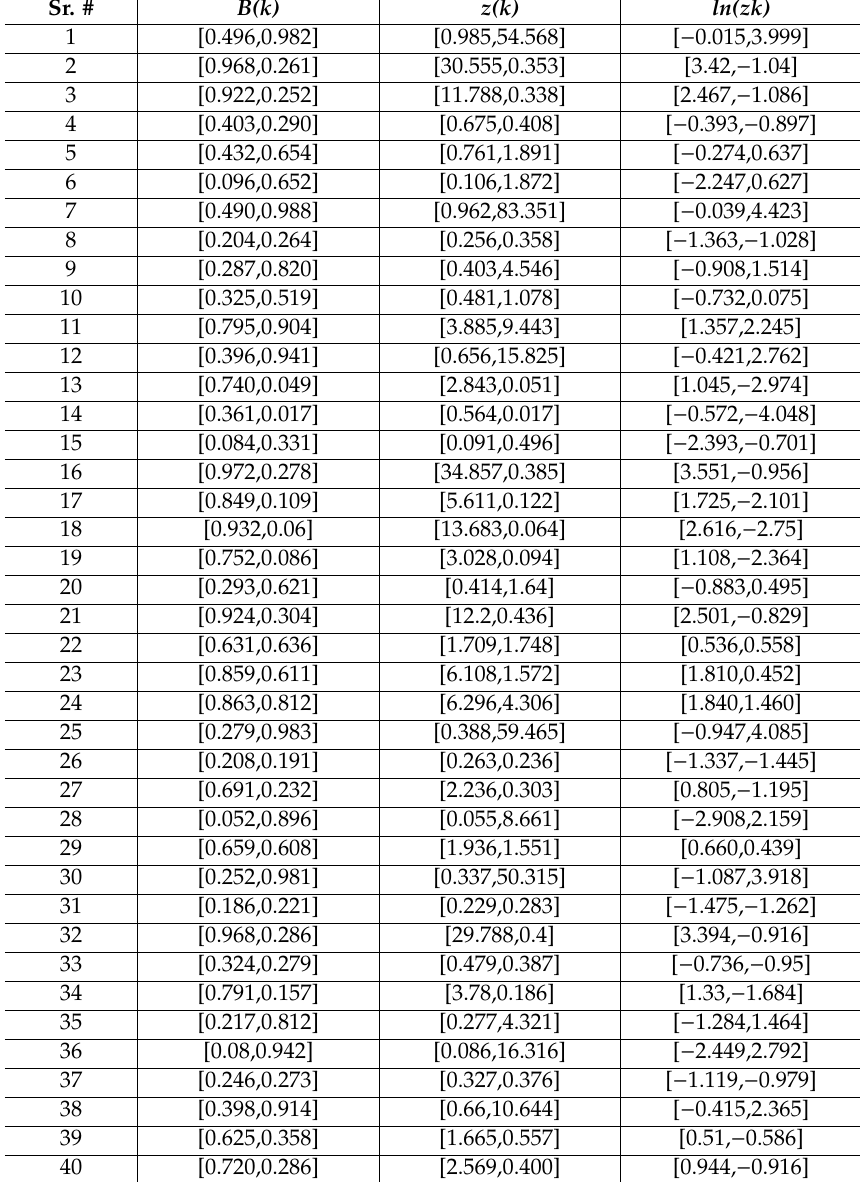
Table 6. The data for a real